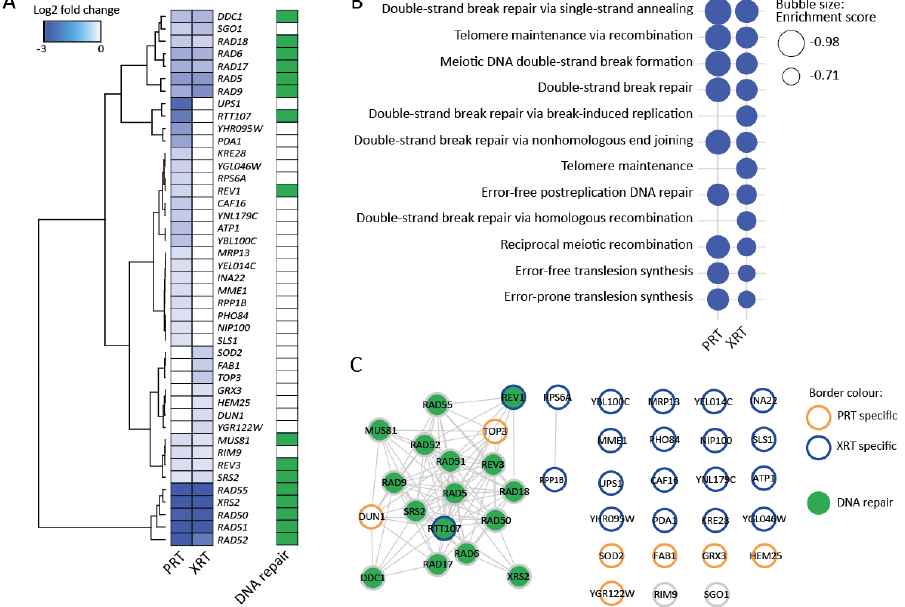
Figure 3. Barcode sequencing (Bar-Seq) experiment identifies DNA repair genes as important for the response to proton (PRT) and photon radiotherapy (XRT). ( A ) Heatmap for sensitive gene deletions. Sensitive gene deletion mutants were selected based on two cut-offs: FDR < 0.05 and log2FC < − 0.5 in either the PRT or XRT experiment. Hierarchical clustering was performed by the Ward.D2 method based on the Euclidian distance. Dark green squares indicate genes annotated with the GO term “DNA repair”. ( B ) Enriched GO terms identified using GSEA. GSEA was applied on a ranked gene list based on the log2FC calculated in edgeR. Genes were chosen based on two cut-offs: false discovery rate (FDR) < 0.05 and log2 fold change (log2FC) < − 0.5 in either the proton or photon experiment. For GSEA, the FDR was set at 0.25. ( C ) Interaction network of genes in ( A ). The network was built in String [43] and visualized in Cytoscape [44]. Nodes with orange borders are deletions only found to be sensitive after PRT. Nodes with blue borders are deletions only found to be sensitive after XRT. Nodes with grey borders are deletions sensitive to both PRT and XRT. Nodes are colored in green when the gene is involved in DNA repair.